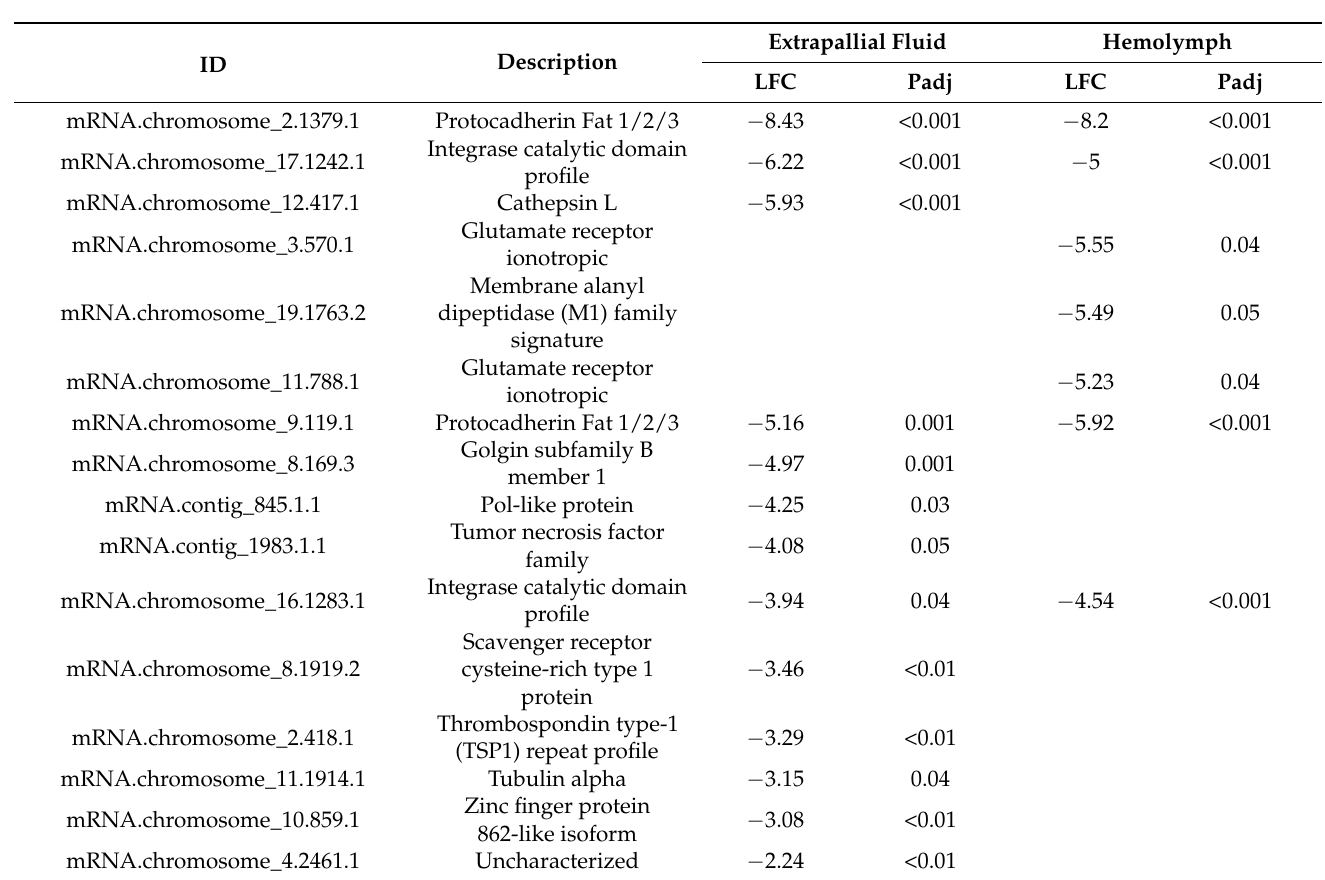
Table 1. Differentially expressed genes in EPF and hemolymph from clams in OA vs. clams in control conditions. Expression level corresponds to the OA treatment. Log2foldchanges (LFC) and adjusted p -values (padj) for each DEG are